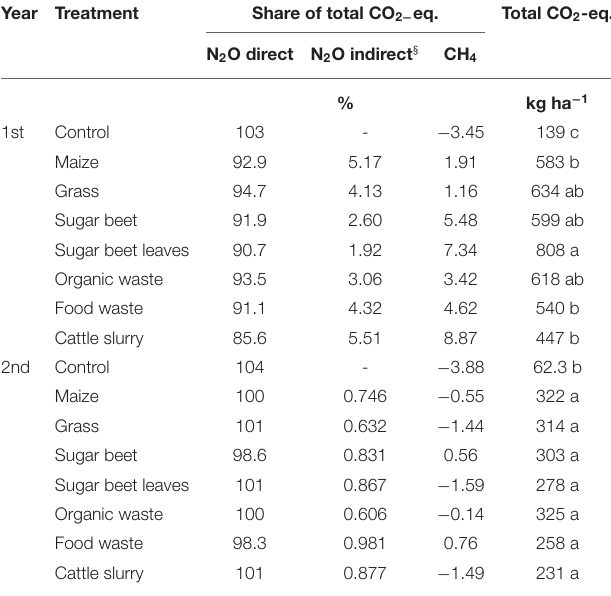
TABLE 7 | Carbon dioxide equivalents (CO 2 -eq.) of unfertilized soil (control) and soil after application of different digestates, originating from maize, grass, sugar beet, sugar beet leaves, organic waste, food waste, and cattle slurry, based on cumulative N 2 O and CH 4 emissions (kg ha − 1 ) after 55 (1st) and 58 days (2nd year); and indirect N 2 O emission as NH 3 -N volatilization over 72h after